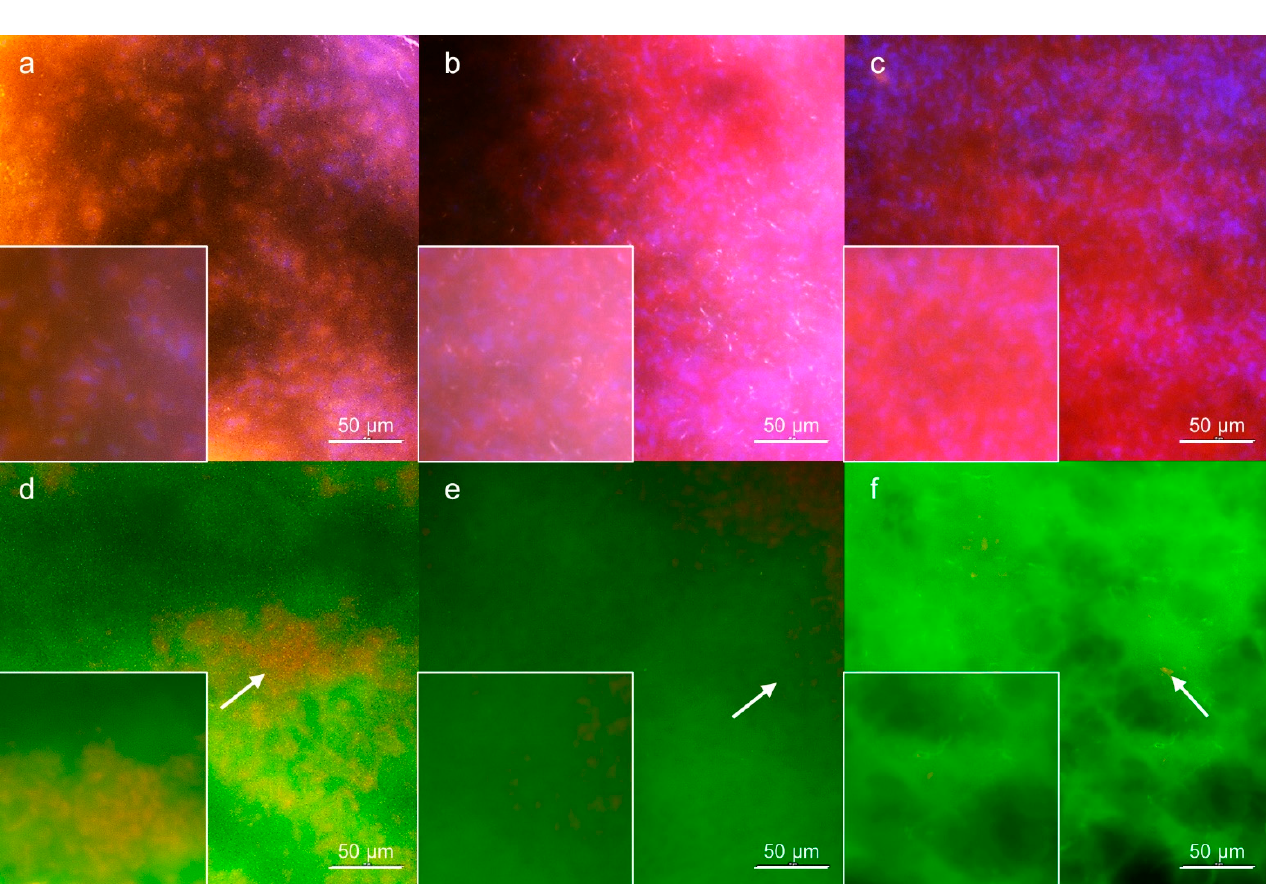
Figure 4. Representative fluorescence microscopy images showing the impact of PUFA administration on lipid peroxidation and apoptosis in wound samples. ( a – c ): BODIPY™ 581/591 C11 lipid peroxidation sensor; ( a ) control group, ( b ) group A, ( c ) group B. The rate of lipid peroxidation corresponds to the red/green fluorescence ratio. Nuclei were counterstained with DAPI (blue fluorescence). Staining indicates an increase in the lipid peroxidation in control group ( a ) compared to groups A ( b ) and B ( c ). ( d , e ): Acridine orange/ethidium bromide staining; ( d ) control group, ( e ) group A, and ( f ) group B. Staining visualizes apoptotic nuclei (red fluorescence). Note the clustering of apoptotic nuclei in the control group ( d ) and their relatively regular distribution in groups A ( e ) and B ( f ) (white arrows). The insets represent magnified details. The bars represent 50 μ m.